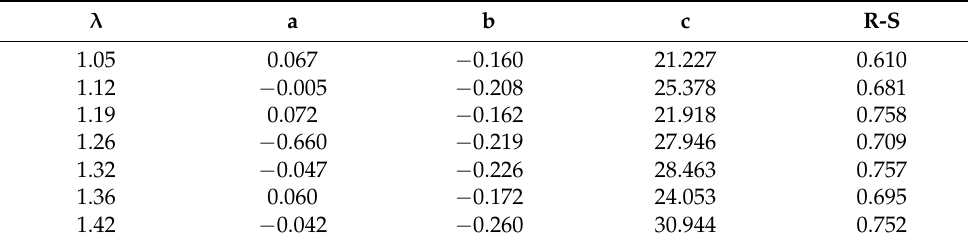
Table 9. Fitting parameters of CA50-CA05 and PMAX distribution under different λ .